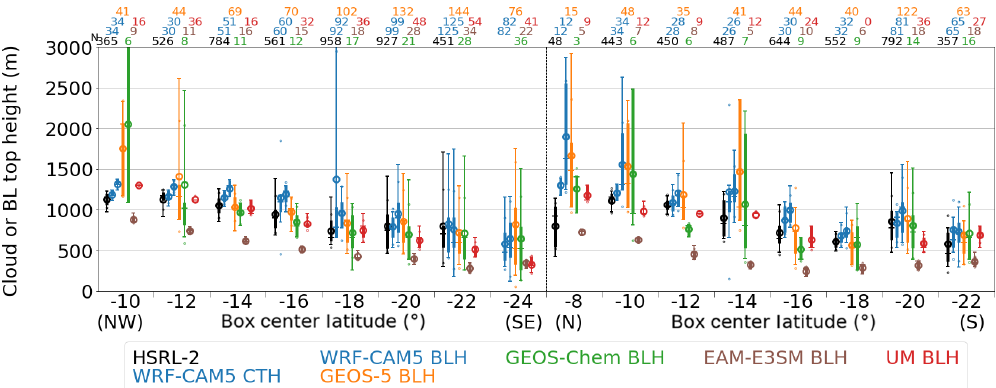
Figure 16. Cloud top heights (CTHs) as measured by the HSRL-2 and depicted by WRF-CAM5, and boundary layer heights (BLHs) from WRF-CAM5, GEOS-5, GEOS-Chem, EAM-E3SM, and UM. Cloud top heights are limited to 4km to exclude mid-level